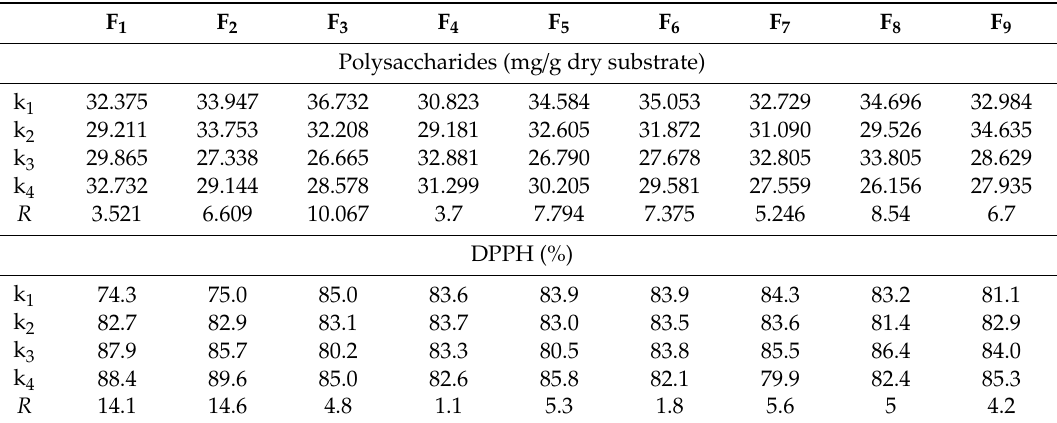
Table 3. Magnitude range analysis of orthogonal